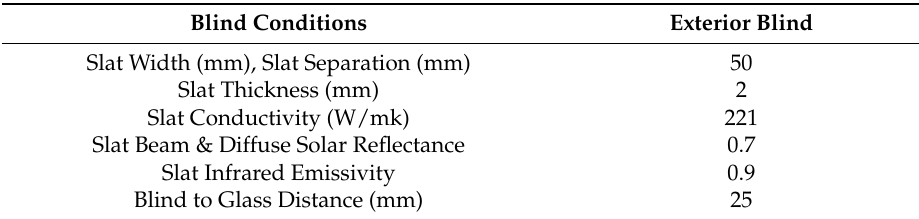
Table 6. Set of the venetian blind slat angle and dimensions.